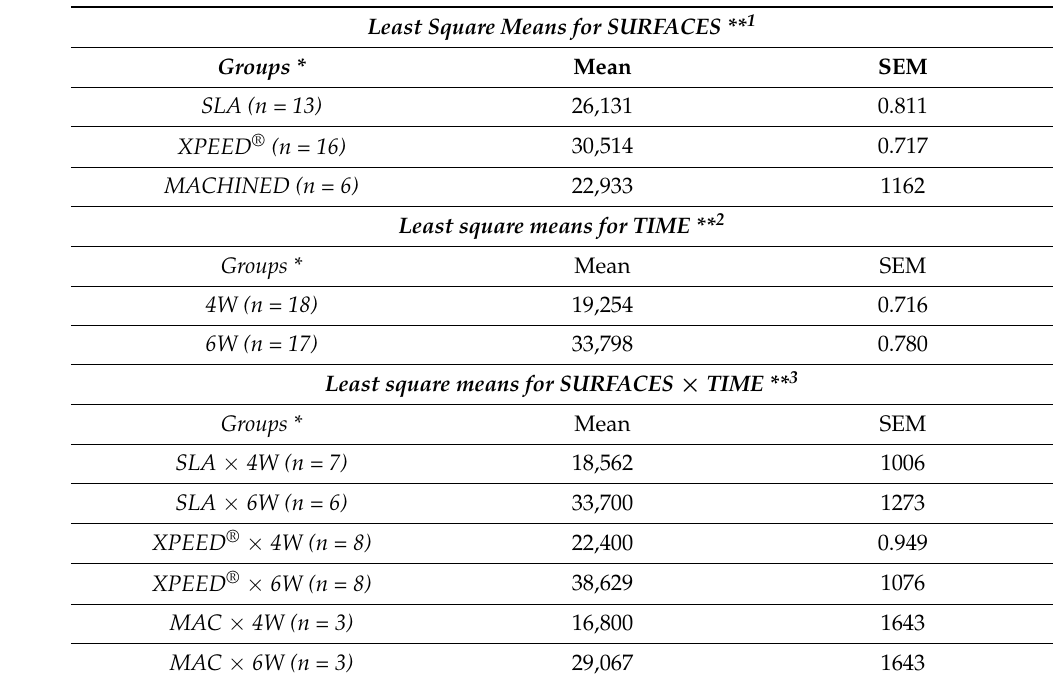
Table 3. Summary of least square means of BIC for groups that are adjusted for means of surfaces, time, surface x time.